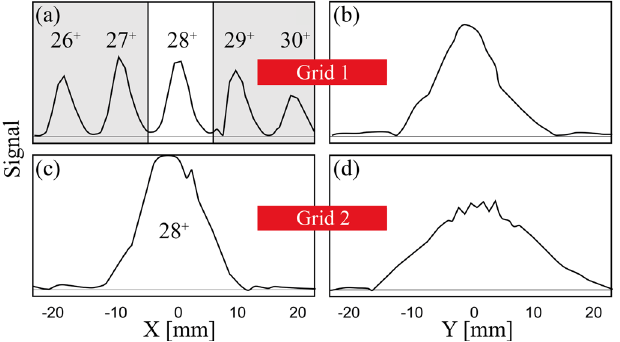
FIG. 3. High-current grid measurements of an 238 U beam before (top) and after (bottom) passing Slit 2 (see Fig. 1) in horizontal (left) and vertical (right) plane. The desired charge peak is selected by adjusting the width of the slit, as indicated in panel (a)